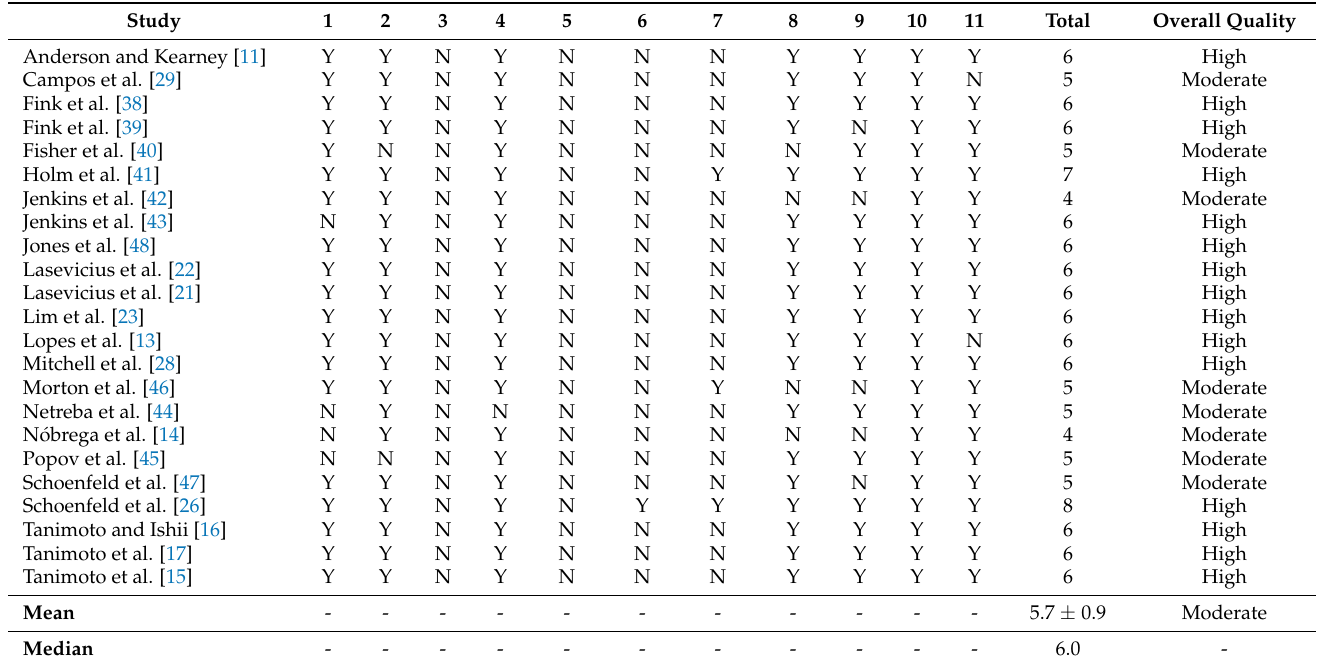
Table 4. Methodological quality of the included